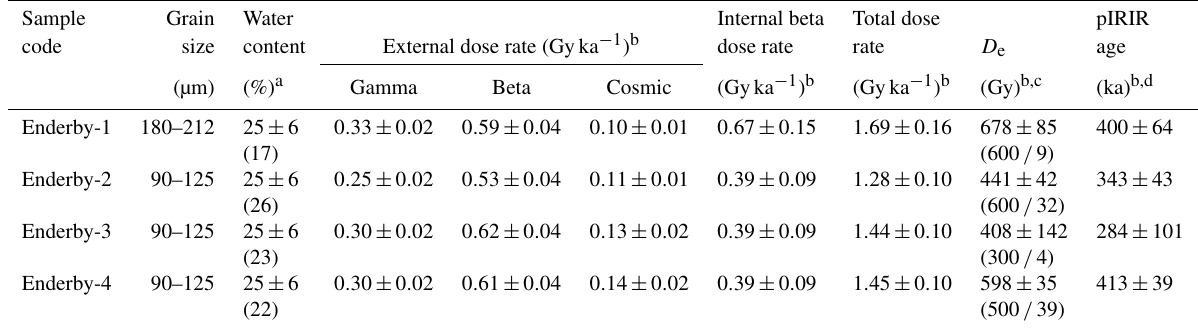
Table 3. Dose rates, equivalent dose ( D e ) values and post-infrared IRSL (pIRIR) ages for the Enderby samples. Sample Grain Water Internal beta Total dose pIRIR